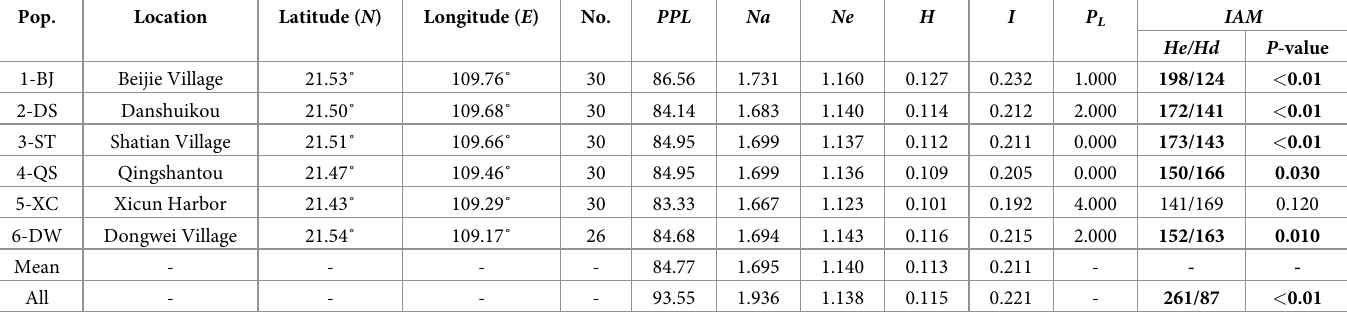
Table 1. Location information, number of sampled individuals, genetic diversity, and recent bottlenecks of the six populations of Spartina alterniflora in Guangxi, China.